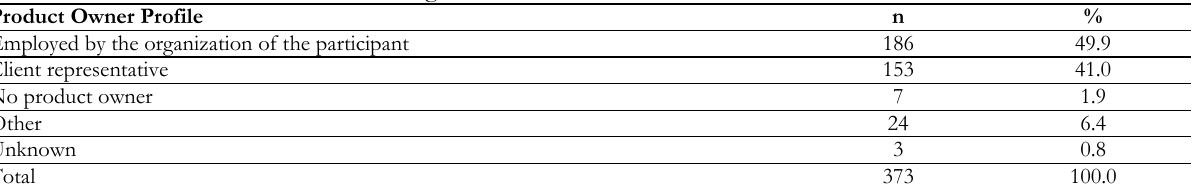
Table 4. Product Owner Profile in the Agile